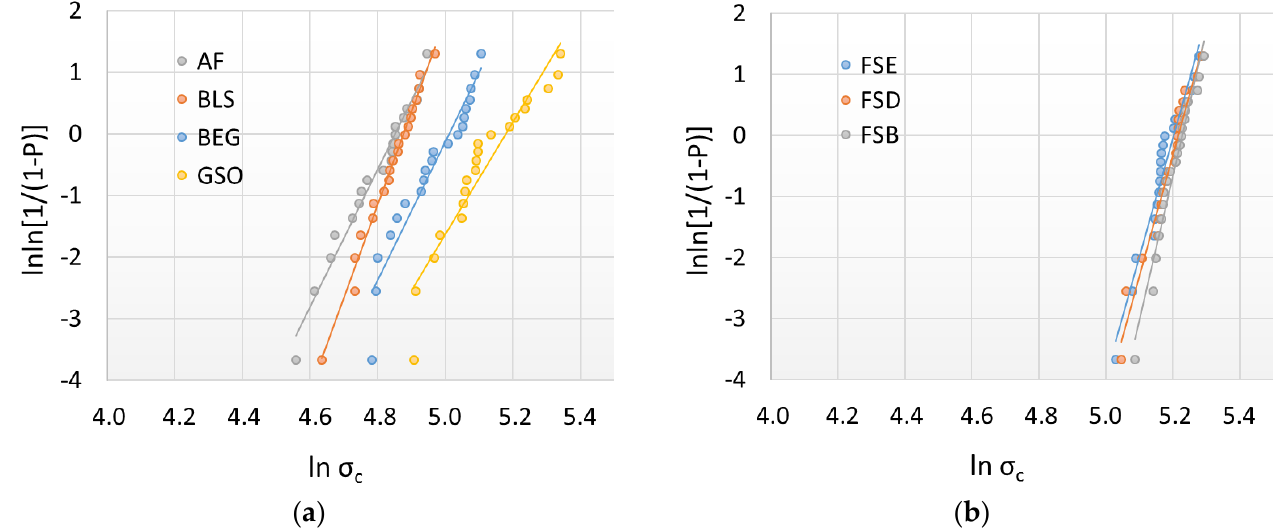
Figure 4. Fracture pattern as a function of material. Material abbreviation: AF = Admira Fusion; BEG = Brilliant EverGlow; BLS = Beautifil II LS; FSB = Filtek Supreme XTE Body; FSD = Filtek Supreme XTE Dentin; FSE = Filtek Supreme XTE Enamel; GSO = Grandio SO.